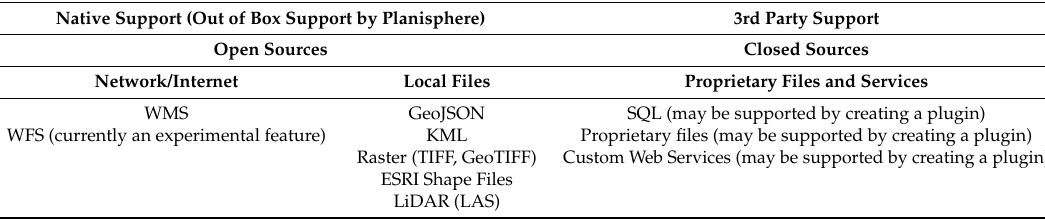
Table 1. Files and Data Sources supported by